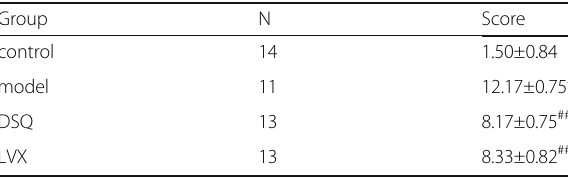
Table 2 Lung Injury Score (mean ± SD) Group